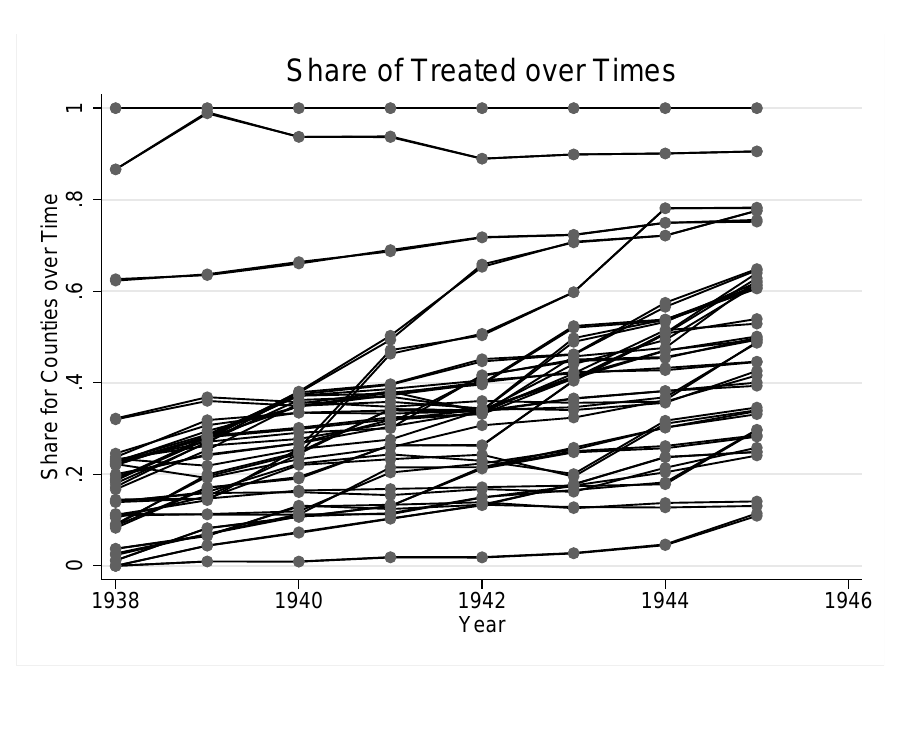
Figure 2. Share of treated school